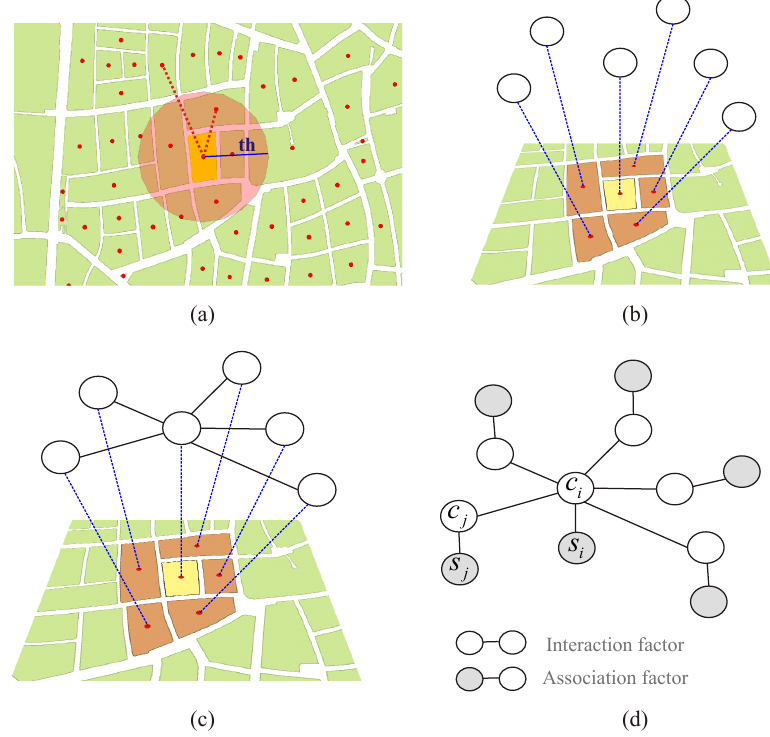
Figure 1. Construction of a simple undirected probabilistic graphical model for the classification of urban structure types. ( a ) Blocks are considered neighbors if the Euclidean distance between their centers of mass is not larger than a threshold (th). ( b ) Each block’s unobserved class c i is represented in the graph by a node. ( c ) An edge is created between each pair of neighboring blocks, thus forming an interaction factor. ( d ) If it is defined that, besides its neighbors unobserved variable c j , c i also depends on its observed attributes s i . The number of association factors in the graph equals the number of blocks in the study site. The number of pairwise interaction factors in the graph equals the number of pairs of neighboring